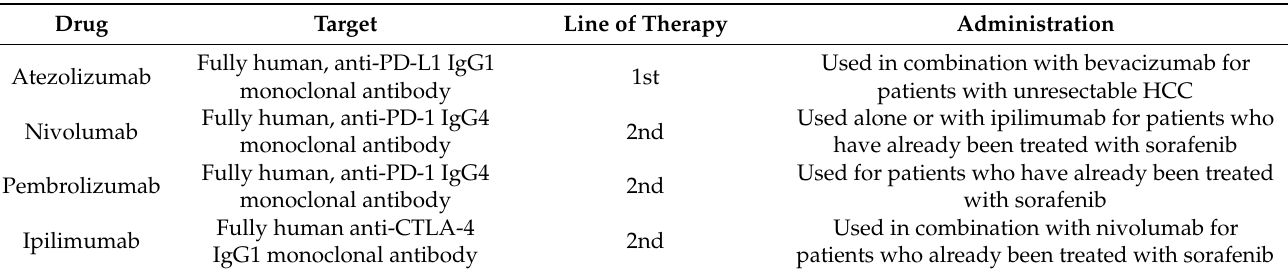
Table 1. FDA-approved checkpoint molecules in